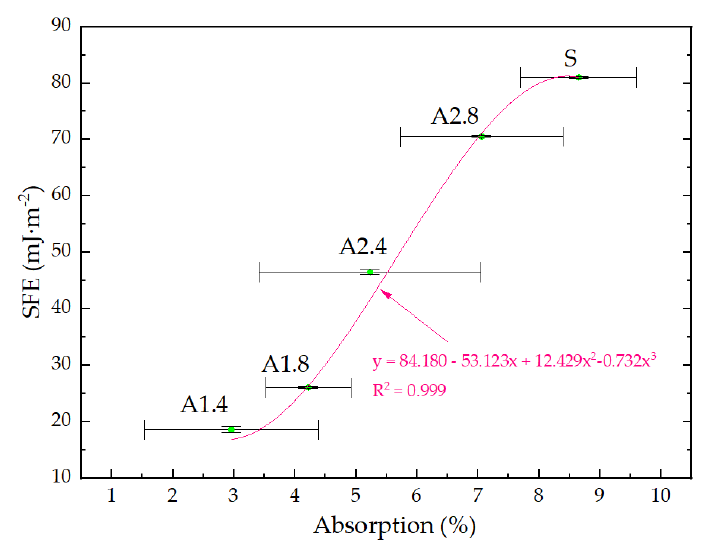
Figure 6. Correlation between absorption and SFE.